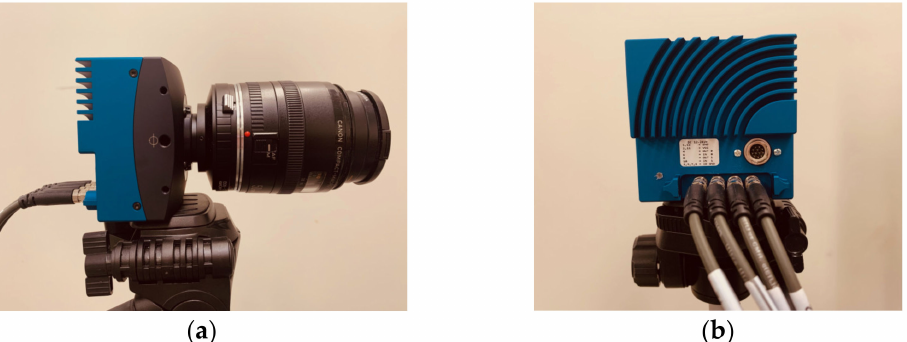
Figure 1. Mikrotron EoSens 1.1CXP2 camera used for data acquisition, with side ( a ) and back ( b )